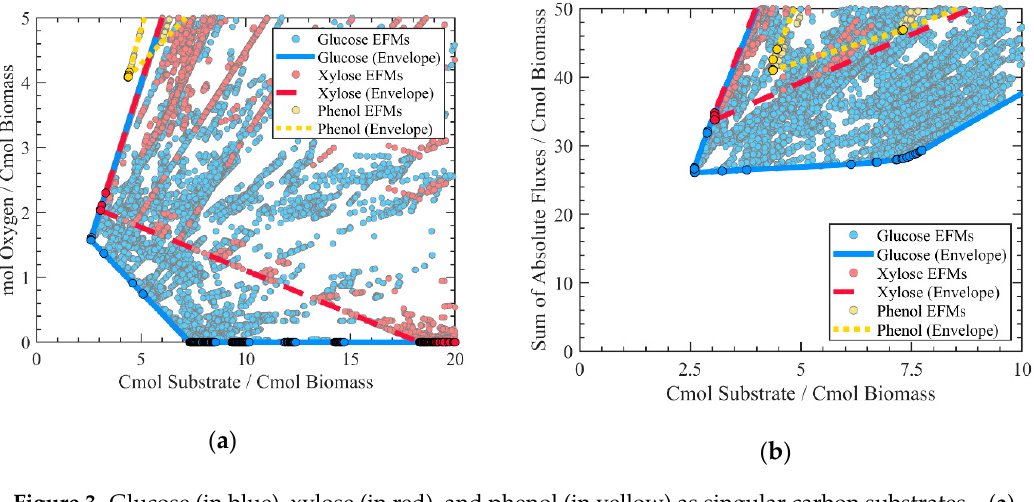
Figure 3. Glucose (in blue), xylose (in red), and phenol (in yellow) as singular carbon substrates—( a ) oxygen cost as a function of carbon substrate cost (moles of oxygen versus moles of carbon consumed in substrate, normalized to moles of carbon in biomass); ( b ) pathway investment e ffi ciency as a function of carbon substrate cost (sum of absolute fluxes per pathway versus moles of carbon consumed in substrate, normalized to moles of carbon in biomass). Each point on the plot represents the reaction ratio for an EFM in the simulation; EFMs closer to the origin represent more e ffi cient pathways.